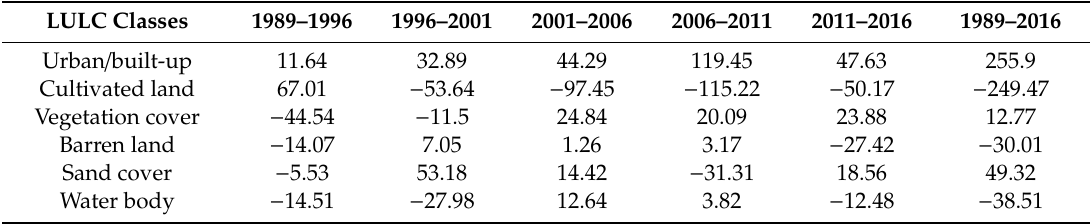
Table 2. Land-use and land-cover (LULC) change over different periods between 1989 and 2016 (in km 2 ).